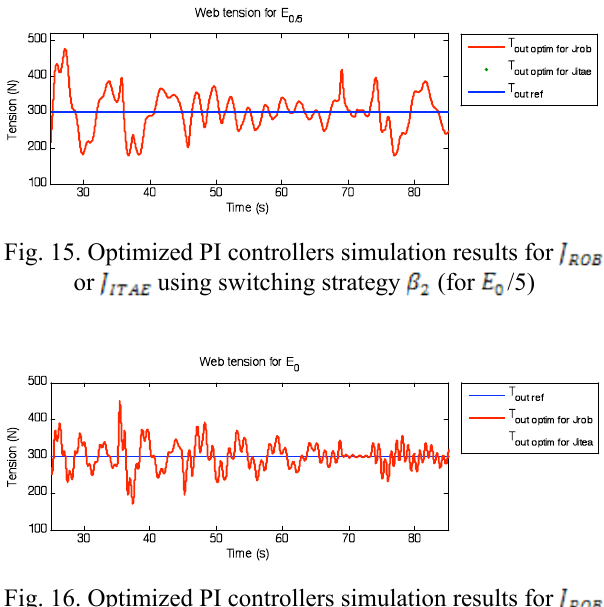
Fig. 16. Optimized PI controllers simulation results for or using switching strategy (for